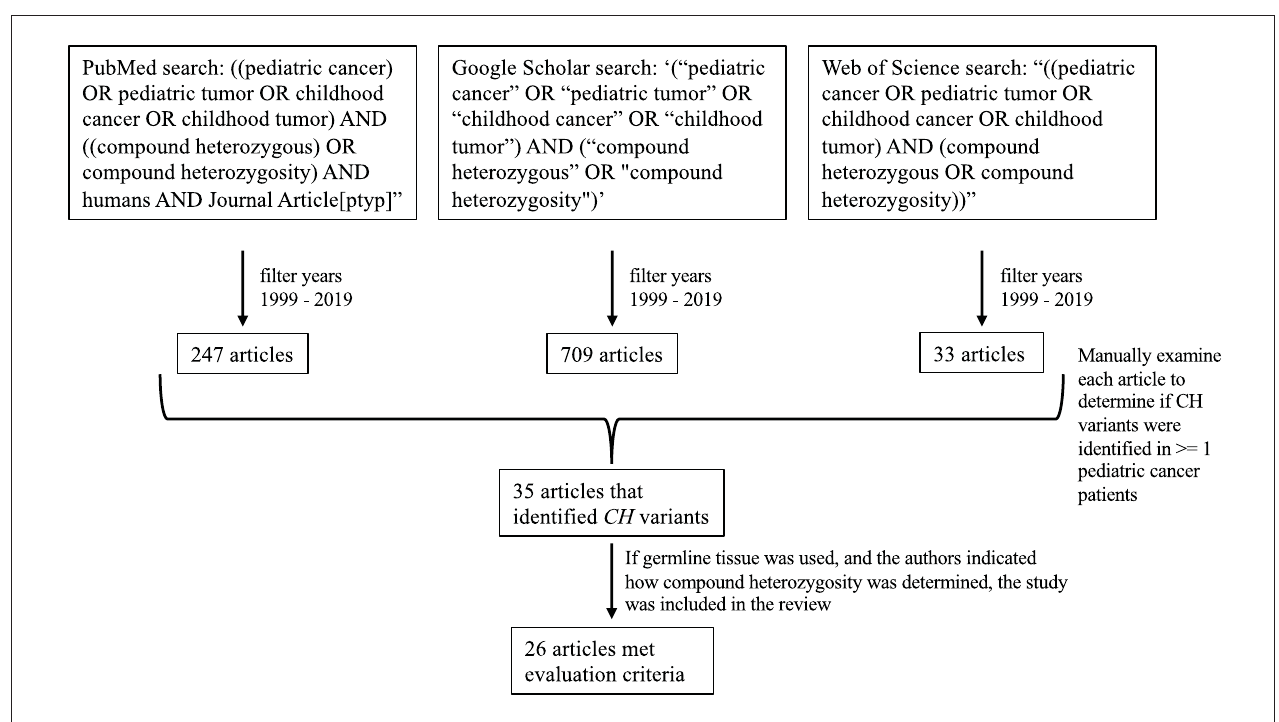
FIGURE 2 | Flow diagram of how the studies in this review were identified. Twenty-six articles met the evaluation